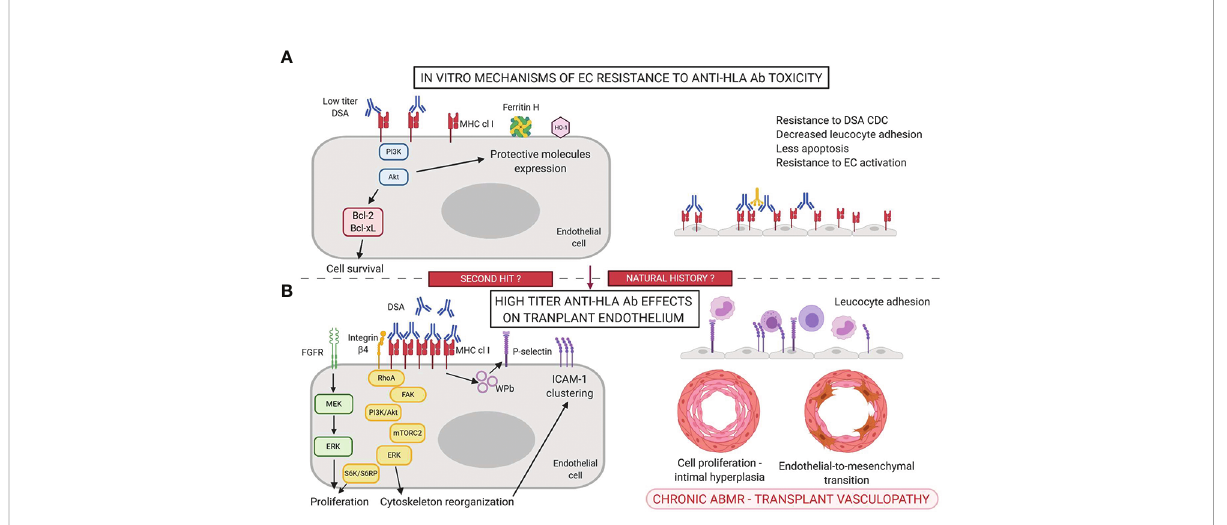
FIGURE 1 Mechanisms of accommodation (A) and antibody-mediated toxicity (B) in the anti-HLA Ab